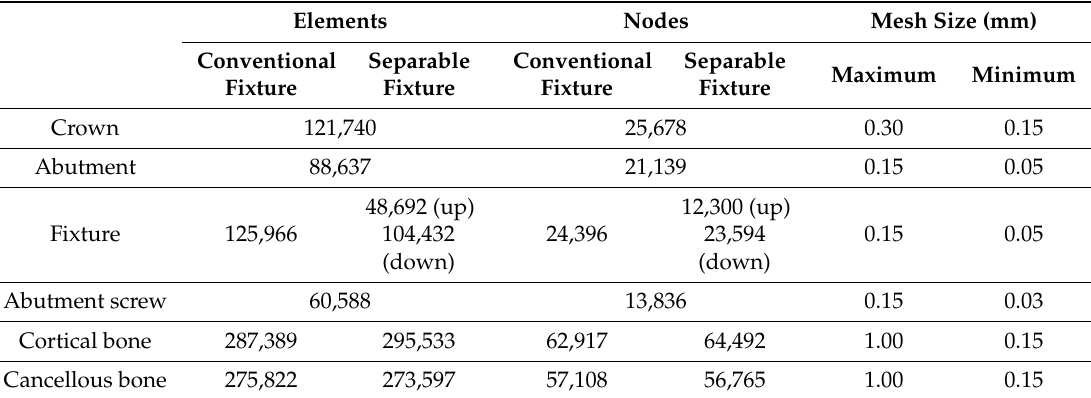
Table 2. Number of elements and nodes for finite element surgical model.